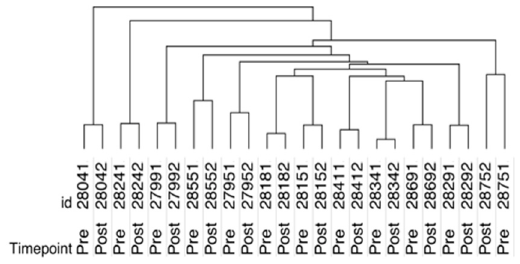
Figure 1. Hierarchical clustering of serum proteomic profiles sorts by patient identity.